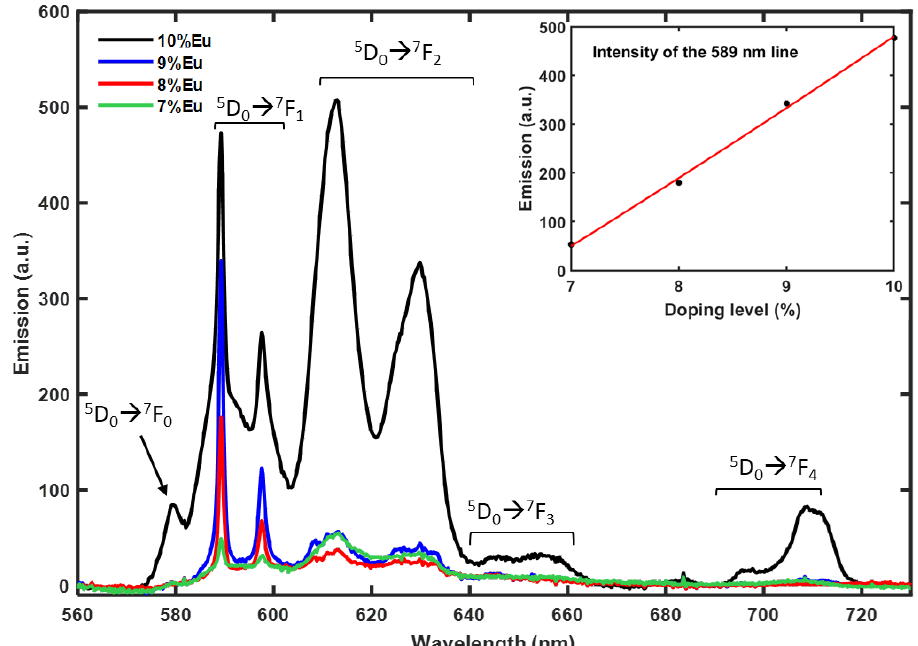
Figure 3. PL intensity of the various compositions under 450 nm excitation. Table 3. Measured length of the samples.